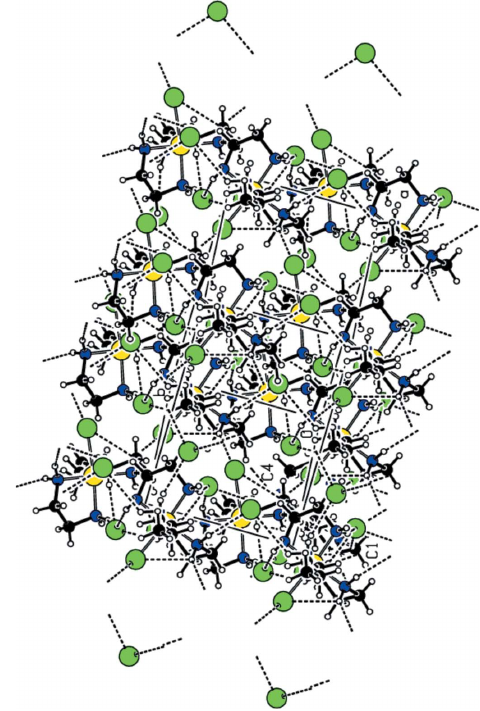
Figure 3 The packing of the title compound viewed along the a axis. Dashed lines indicate hydrogen bonds.